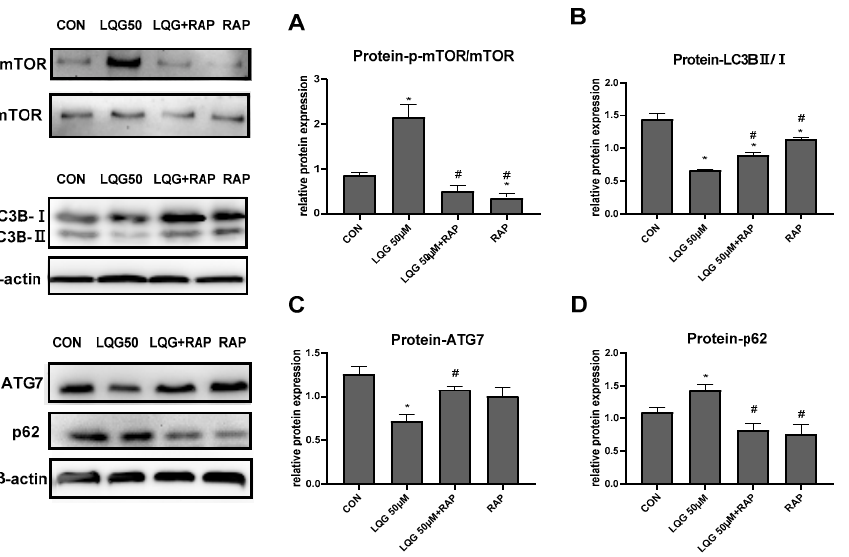
Figure 4. Effects of rapamycin (RAP) on modulating autophagy-related factors in LQG-treated 3T3-L1 cells. The cells were divided into four groups: control group, 50 µ M LQG group, LQG + RAP group, and RAP-alone group. Protein expression of ( A ) p-mTOR and mTOR, ( B ) LC3BII/LC3BI, ( C ) ATG7, and ( D ) p62 were quantified by densitometry, and the relative intensities are expressed in the bar charts. Western blotting bands represent detection of the proteins from three independent tests. Data are presented as means ± SEMs and analyzed with one-way ANOVA. * vs. control group ( p ≤ 0.05); # vs. 50 μ M LQG-alone treatment group ( p ≤ 0.05).